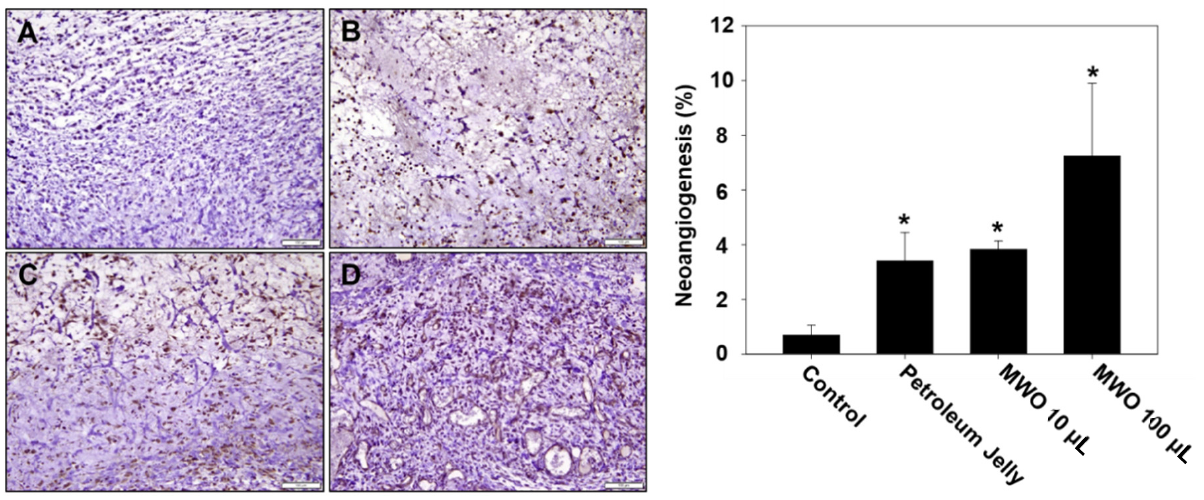
Figure 6. Effect of MWO on angiogenesis in skin wounds of rats. The tissues harvested from the skin wound area of the rats treated with or without MWO were used in immunohistochemistry staining with anti-CD31 to detect neo-vessels. Immunohistochemistry staining of endothelial cells with anti-CD31 is represented by the brown color (magnification ×200). The values are shown as means ± SD. * p < 0.05 compared to the control. ( A ) The skin wound area untreated with MWO. ( B ) Treated with petroleum jelly as a negative control. ( C ) Treated with 10 μ L MWO. ( D ) Treated with 100 μ L MWO.